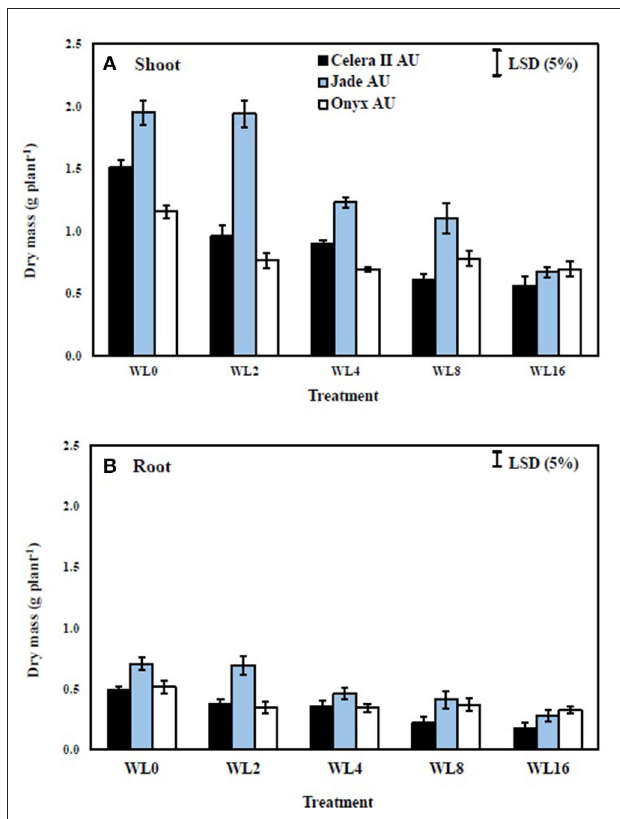
FIGURE 5 | The effect of different waterlogging durations on the shoot (A) and root (B) dry mass of three genotypes after different durations of recovery at 39 DAS: WL2, waterlogging for 2 days, recovery for 22 d; WL4, waterlogging for 4 days, recovery for 20 days; WL8, waterlogging for 8 days, recovery for 16 days; WL16, waterlogging WL 16 days, recovery for 8 days. Bars are mean ( n = 4) ± SE and LSD at P = 0.05 for